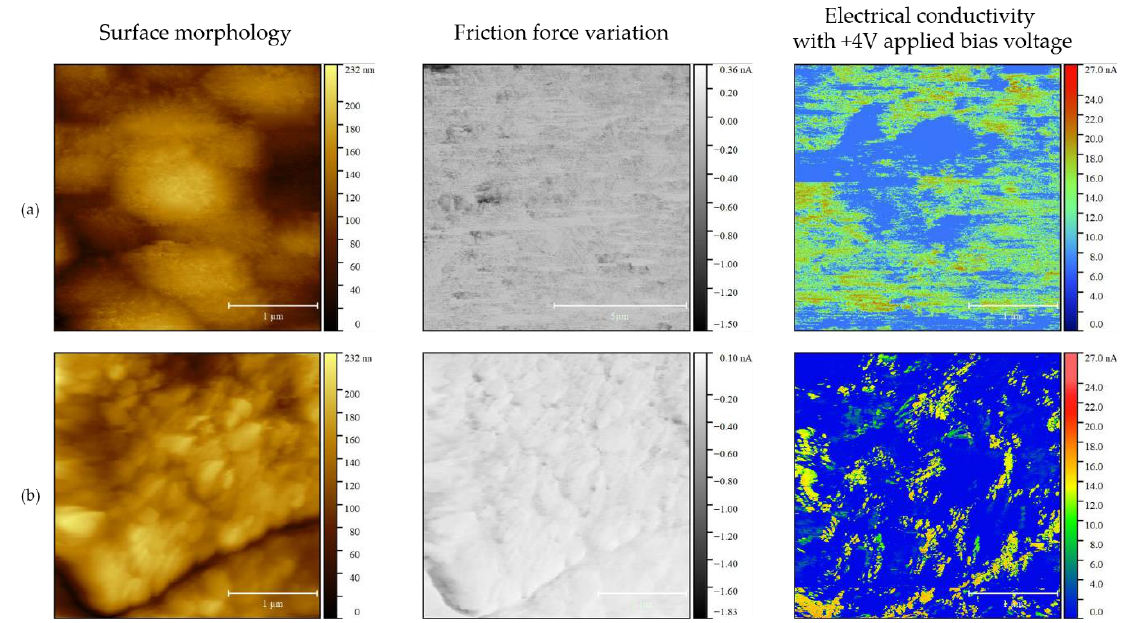
Figure 14. The 3 × 3 µm 2 2D AFM images of: ( a ) NiSn-P3.3-alloy and ( b ) NiSn-rGO-P3.3 composite.